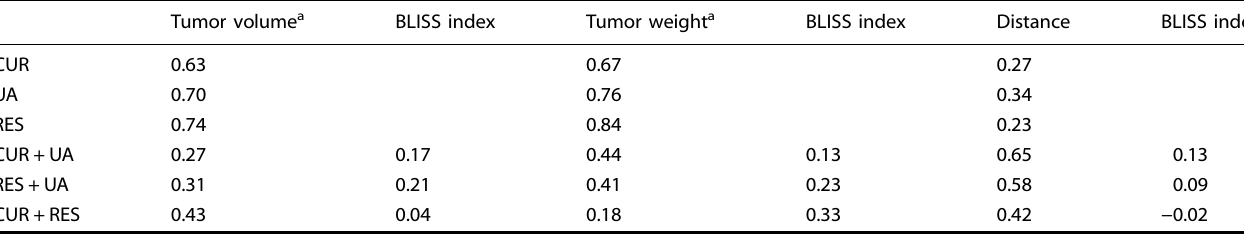
Table 3. Evaluation of synergistic effects by combined treatments in vivo and in